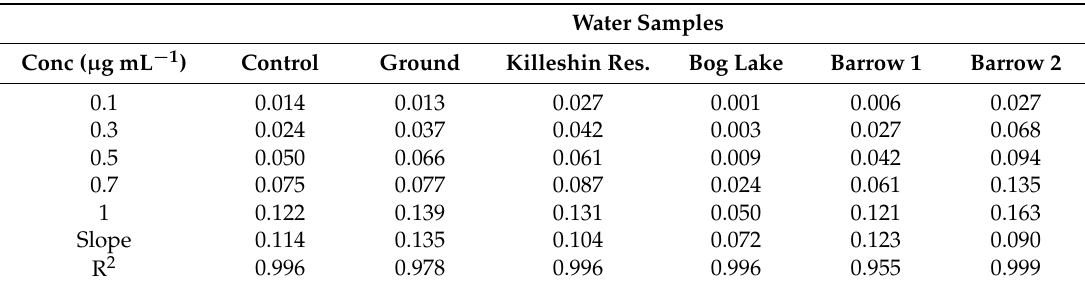
Table 8. The average absorbance of arsenic samples (0.1–1 µ g mL − 1 ) analyzed in different water matrices. The measurements were carried out in triplicate ( n = 90).